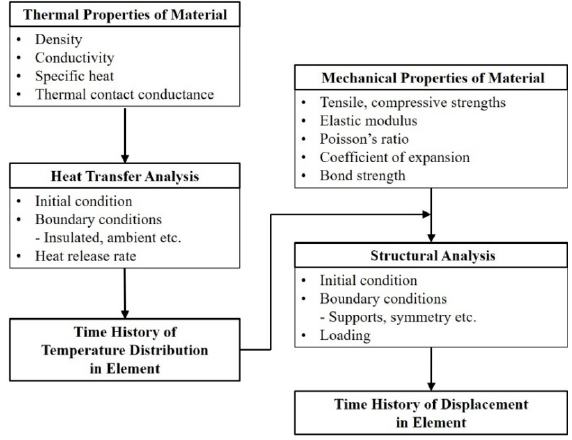
Figure 2. Procedure of the analytical studies for fire resistance.